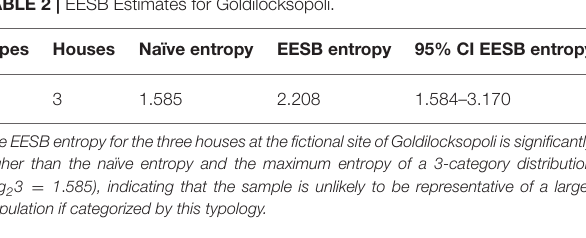
TABLE 2 | EESB Estimates for Goldilocksopoli. TABLE 4 | Entropies for housing at Metaponto based on number of